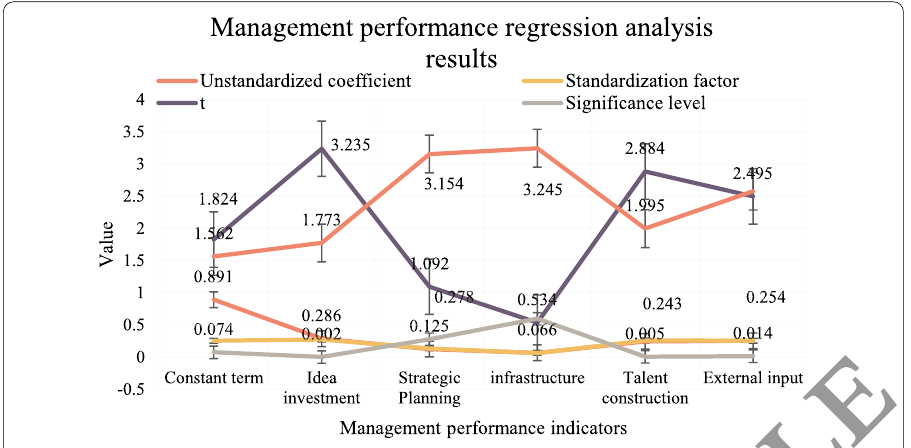
Fig. 6 Management performance regression analysis results